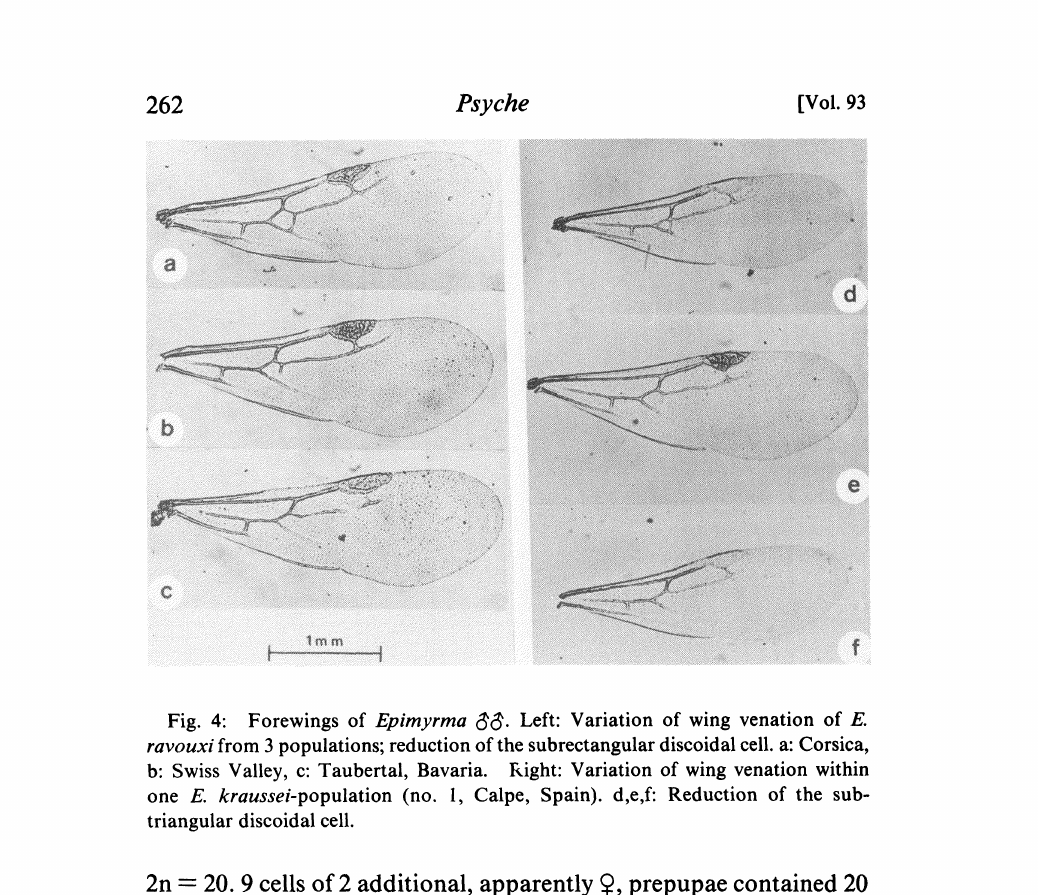
. Left: Variation of wing venation of E. Fig. 4: Forewings of Epimyrma ravouxi from 3 populations; reduction of the subrectangular discoidal cell. a: Corsica, b: Swiss Valley, c: Taubertal, Bavaria. Kight: Variation of wing venation within one E. kraussei-population (no. 1, Calpe, Spain). d,e,f: Reduction of the sub- triangular discoidal